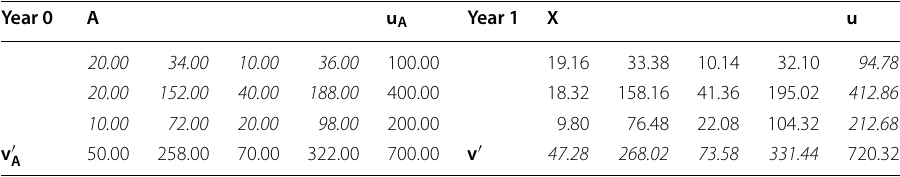
Table 1 Initial matrix and the target marginal totals, Eurostat (2008), p.